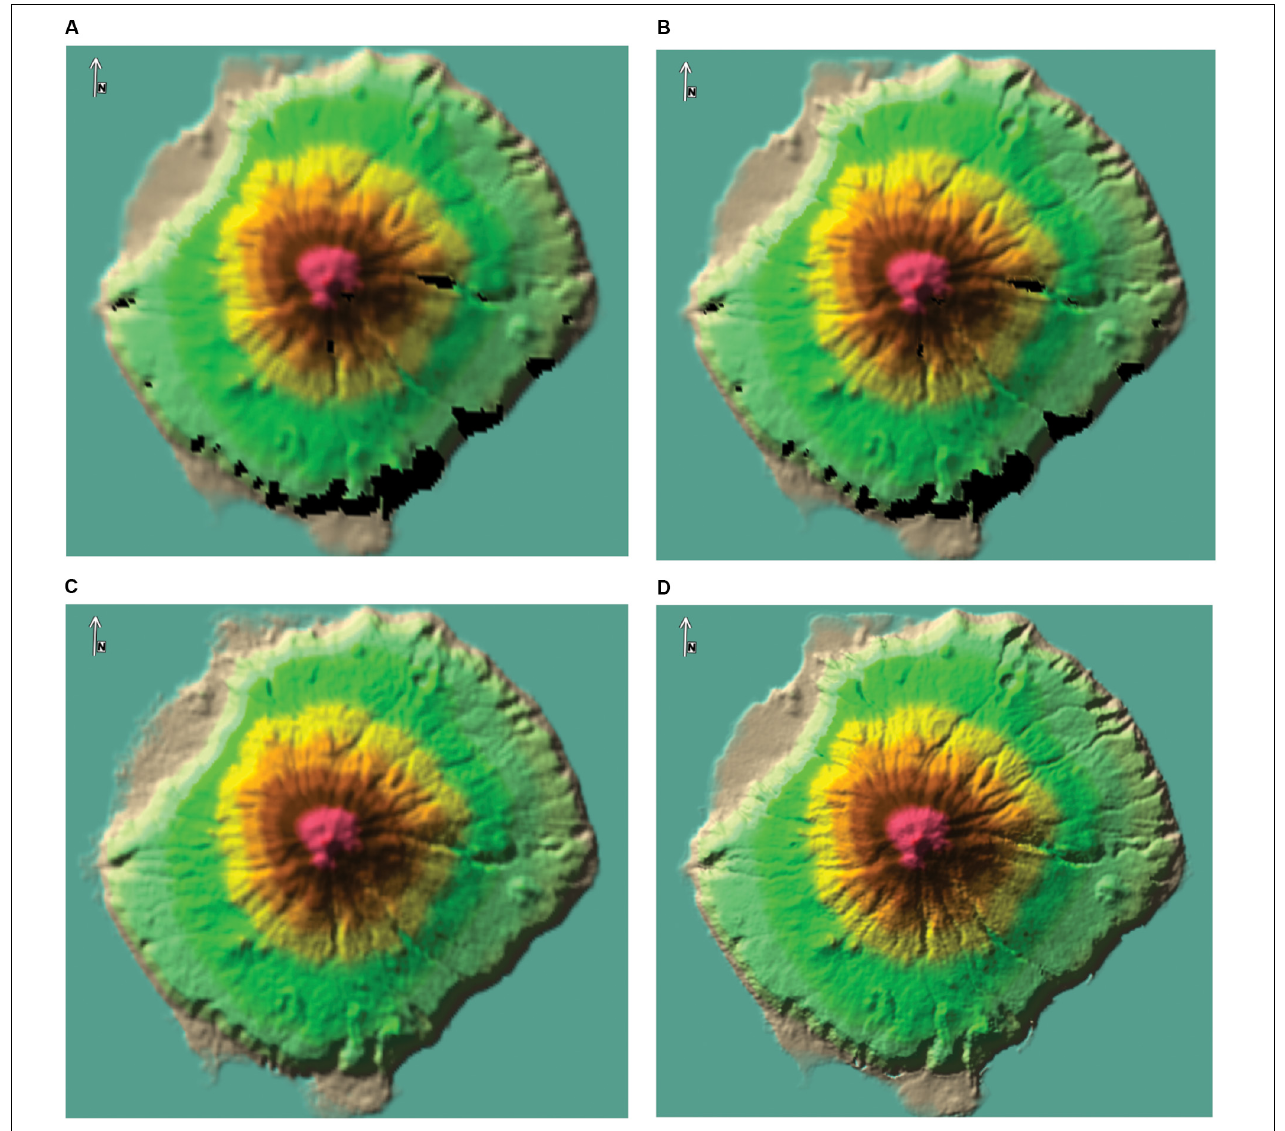
FIGURE 2 | (A) SRTM DEM with 3 (cid:48)(cid:48) GSD. (B) SRTM DEM with 1 (cid:48)(cid:48) GSD. (C) ASTER-GDEM Version 2.0 with 1 (cid:48)(cid:48) GSD. (D) mDEM with 1 (cid:48)(cid:48)